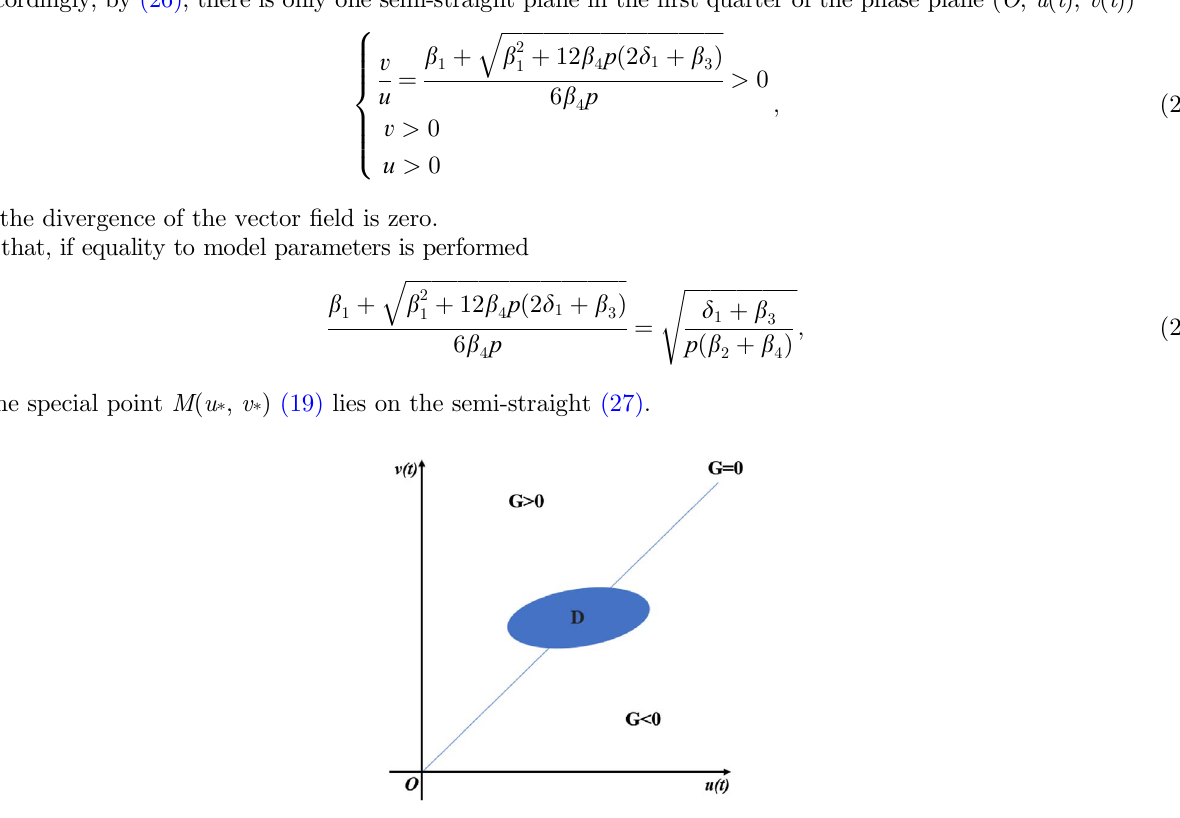
Figure 2. Qualitative picture of the behavior of divergence of the vector fi eld in the fi rst quarter of the phase plane of